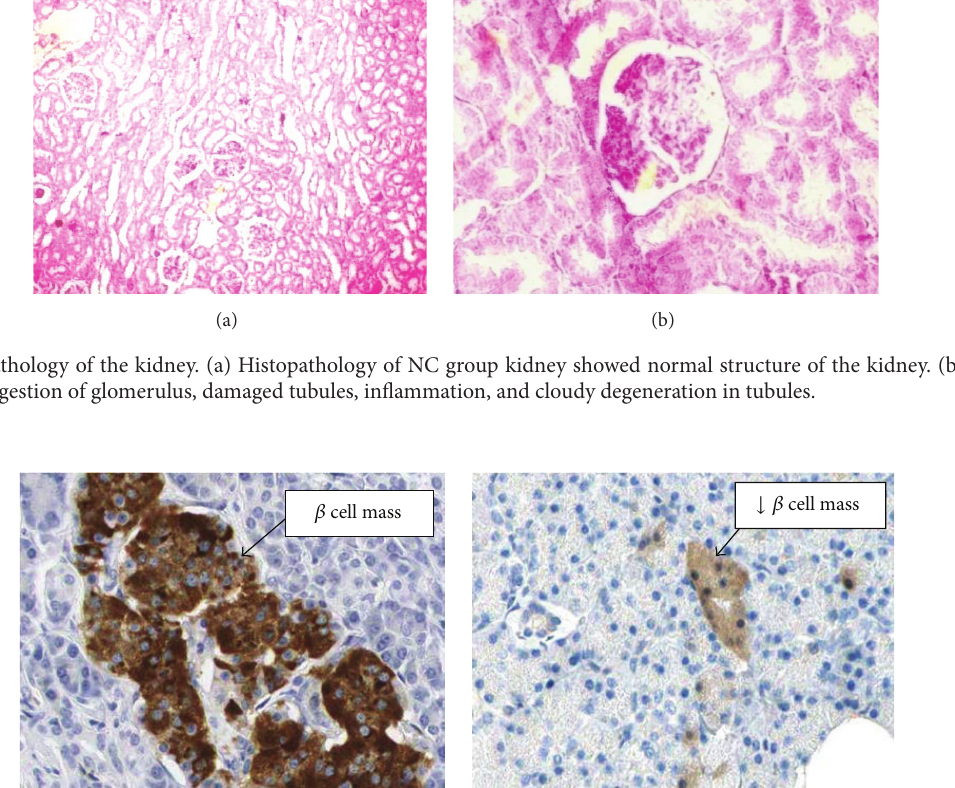
Figure 10: Immunohistochemical localization of insulin. (a) Immunohistochemistry of NC group pancreas showed increased localization of insulin. (b) The HF-DC group showed decreased insulin localization and hence loss of beta cell